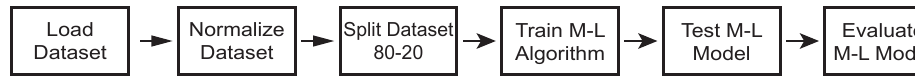
Figure 1. Block diagram for training, testing, and evaluating the ML